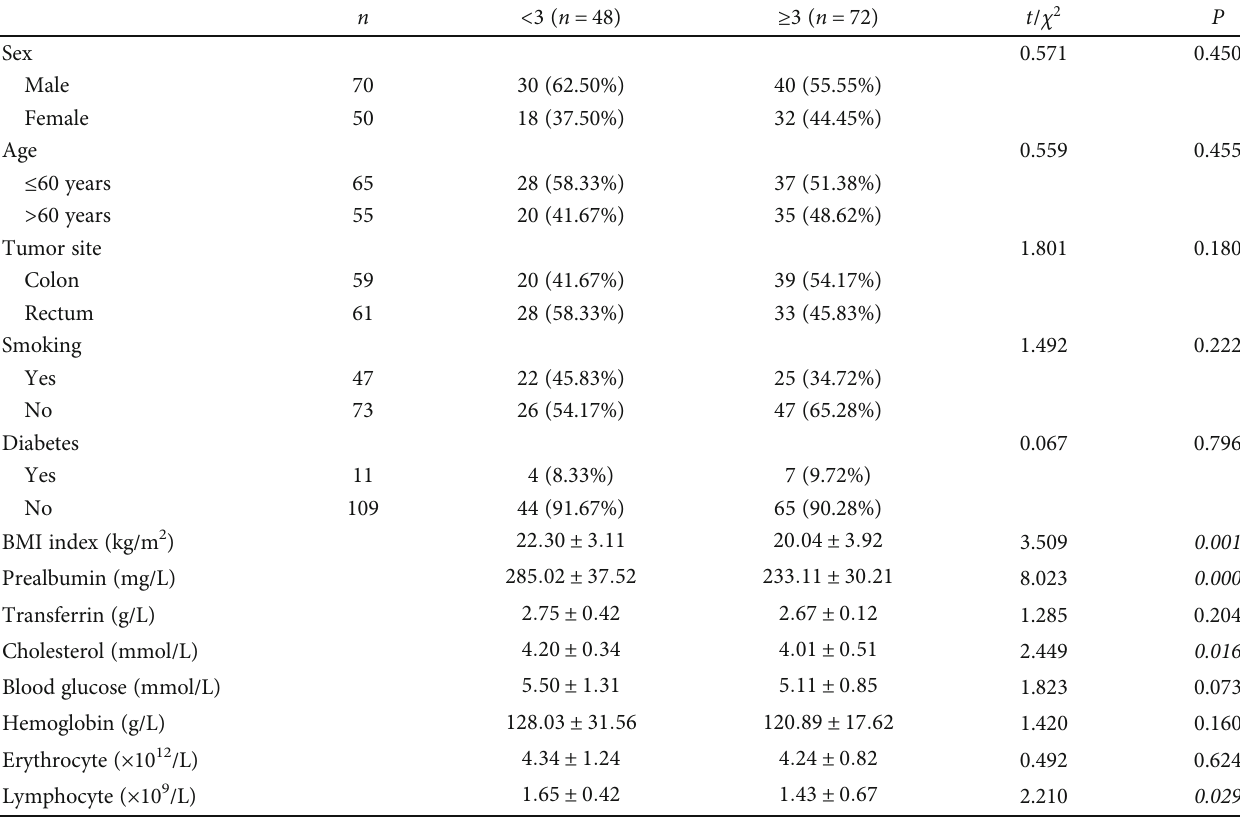
Table 1: Clinicopathological characteristics of two groups.